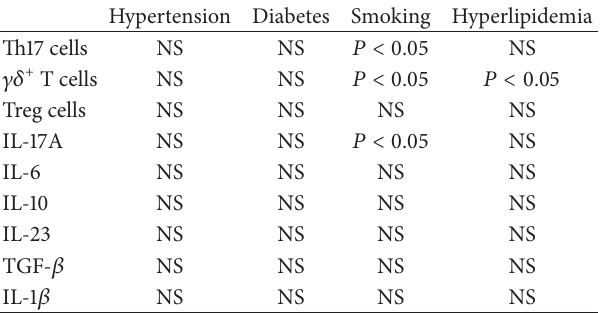
Table 2: The risk factors for T cell subset frequency and cytokine